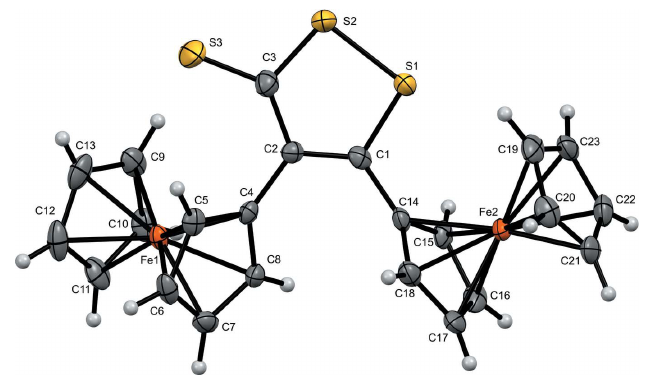
Figure 1 The molecular structure of the title compound, with displacement ellipsoids drawn at the 70% probability